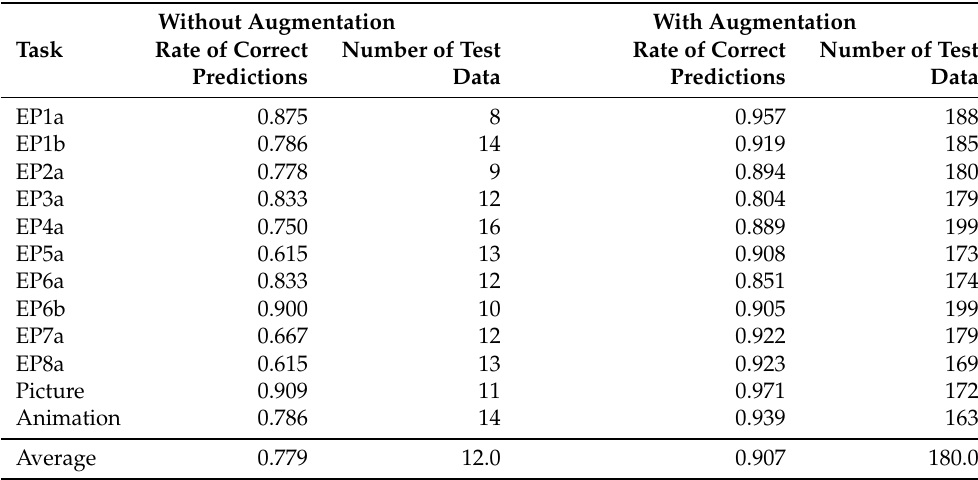
Table 3. Comparison of predicted correctness for each task in a model that classifies all tasks, with and without augmentation. Without Augmentation With Augmentation Task Rate of